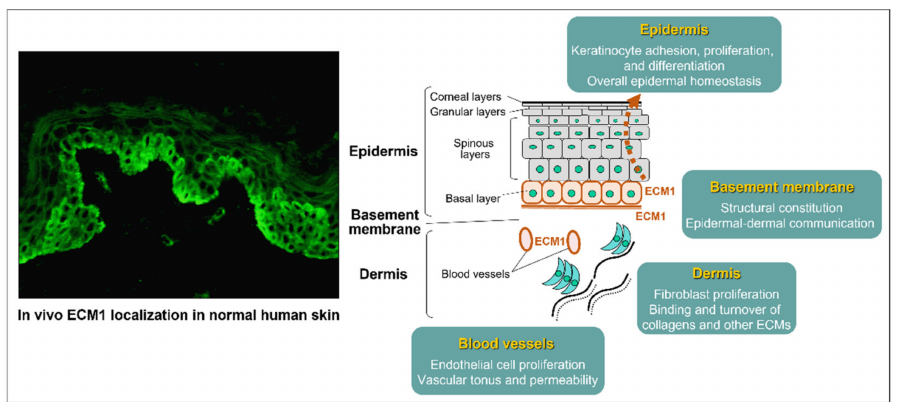
Figure 4. Multifocal interaction of in vivo ECM1 with surrounding extracellular matrix and structural molecules in the skin. ECM1 is expressed in the major skin components (particularly the epidermal basal layer and basement membranes) and adjunct appendages (blood vessel walls and follicular epithelium), as immunostained in normal human skin ( left panel ), and regulates the different in vivo turnover and feedback productivity of binding partners as a ‘biological glue’, contributing to the integrity and maintenance of skin homeostasis ( right panel